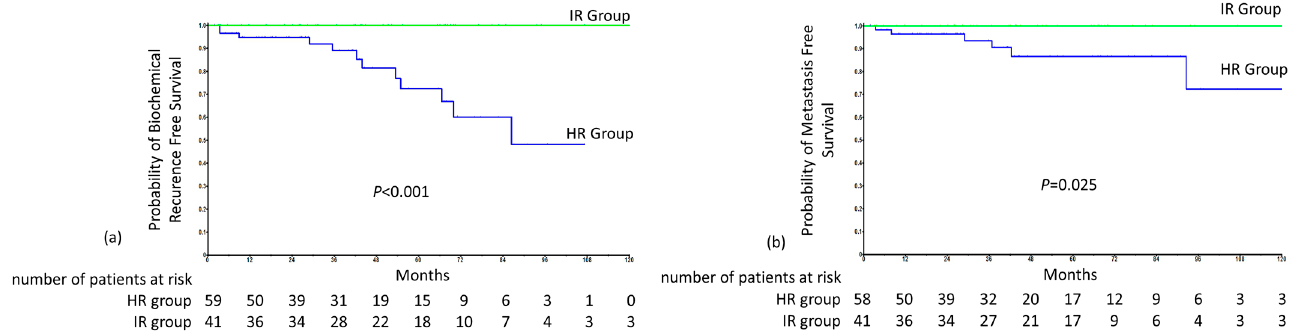
Figure 2. Survival in groups A and B, panel ( a ) represents biochemical recurrence-free survival (BRFS) and numbers at risk for both A and B groups, panel ( b ) represents distant metastasis-free survival (DMFS) and numbers at risk for both A and B groups. Table 3. Biochemical recurrence-free survival (BRFS) and Distant metastasis-free survival (DMFS) in high-risk ≥ 80 years patients (group B; n = 60) . Univariate analysis.